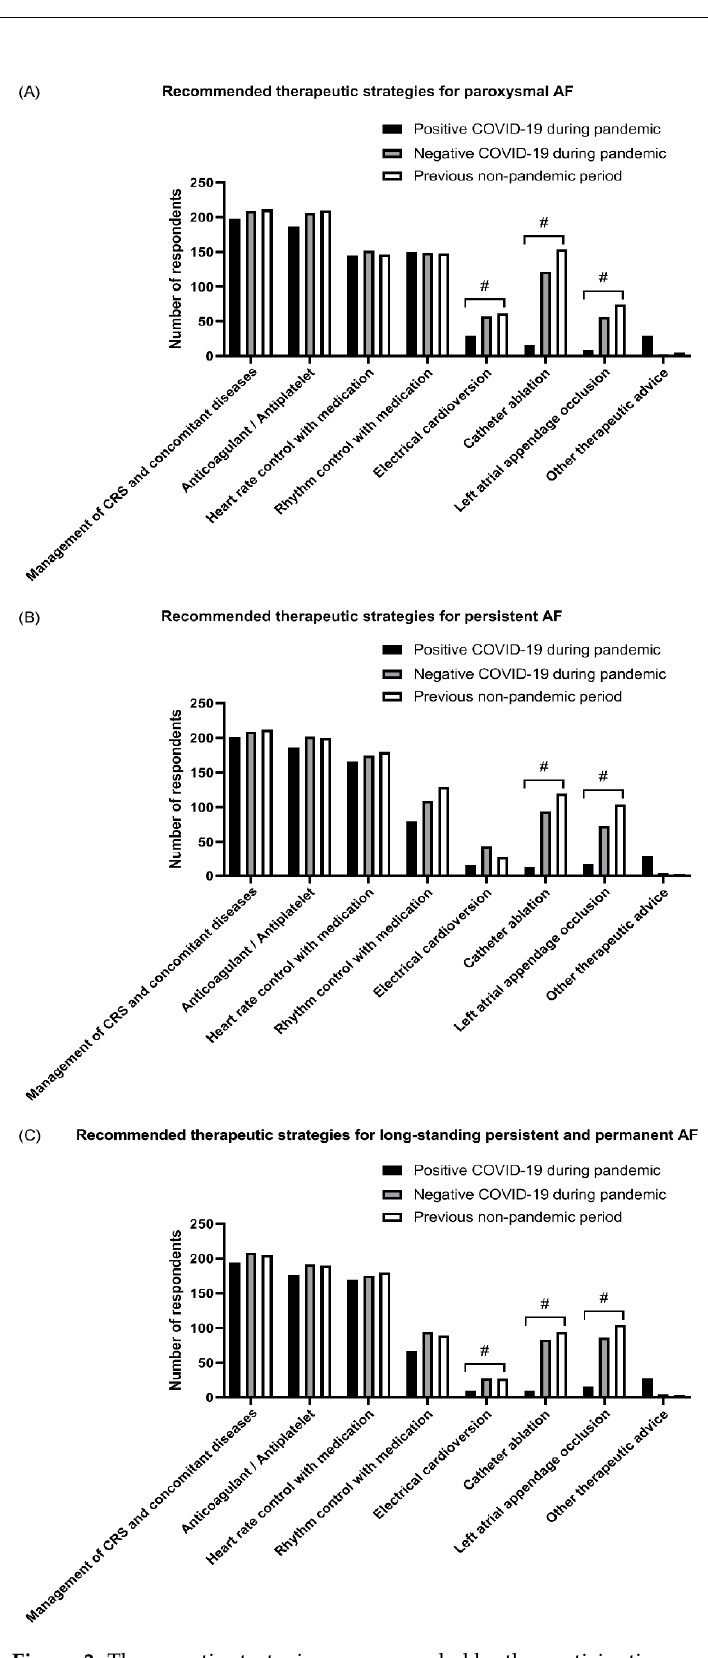
Figure 3. Therapeutic strategies recommended by the participating cardiologists. ( A ) Recommended therapeutic strategies for paroxysmal AF. ( B ) Recommended therapeutic strategies for persistent AF. ( C ) Recommended therapeutic strategies for long-standing persistent and permanent AF. #, p < 0.05.